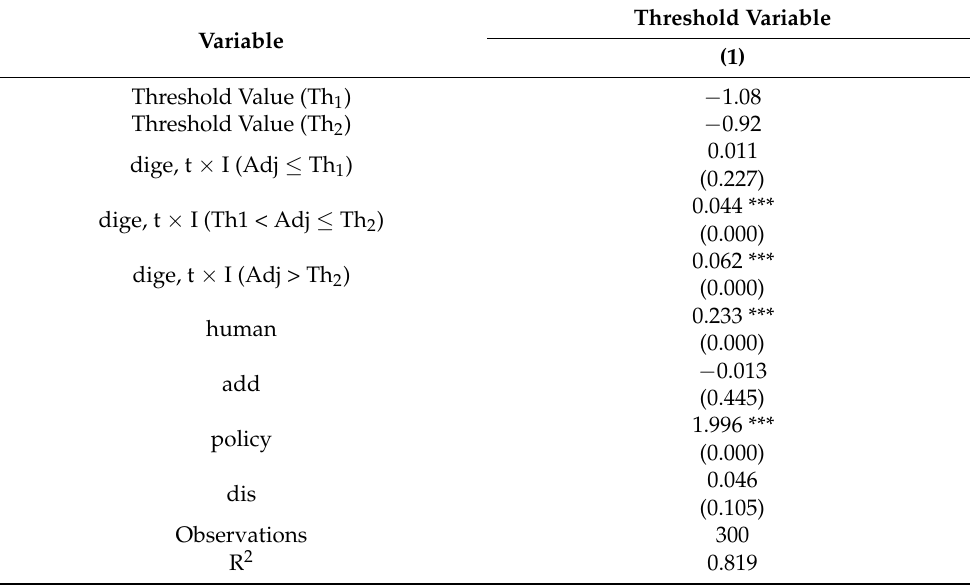
Table 6. Threshold regression